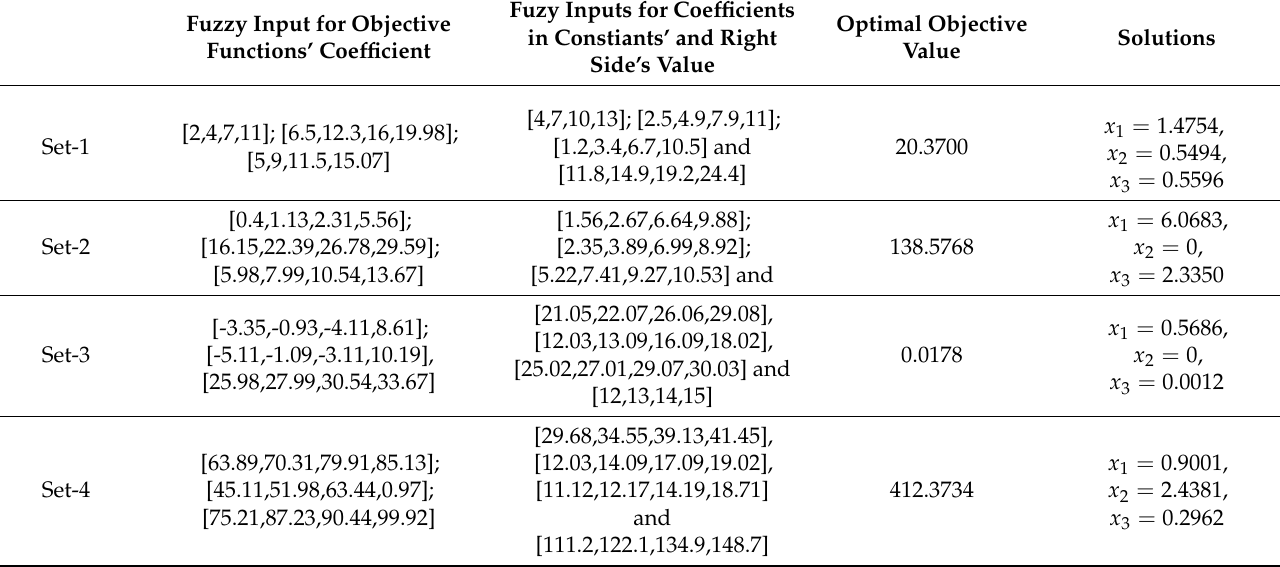
Table 1. Optimum results comparison for a different set of fuzzy inputs with the proposed